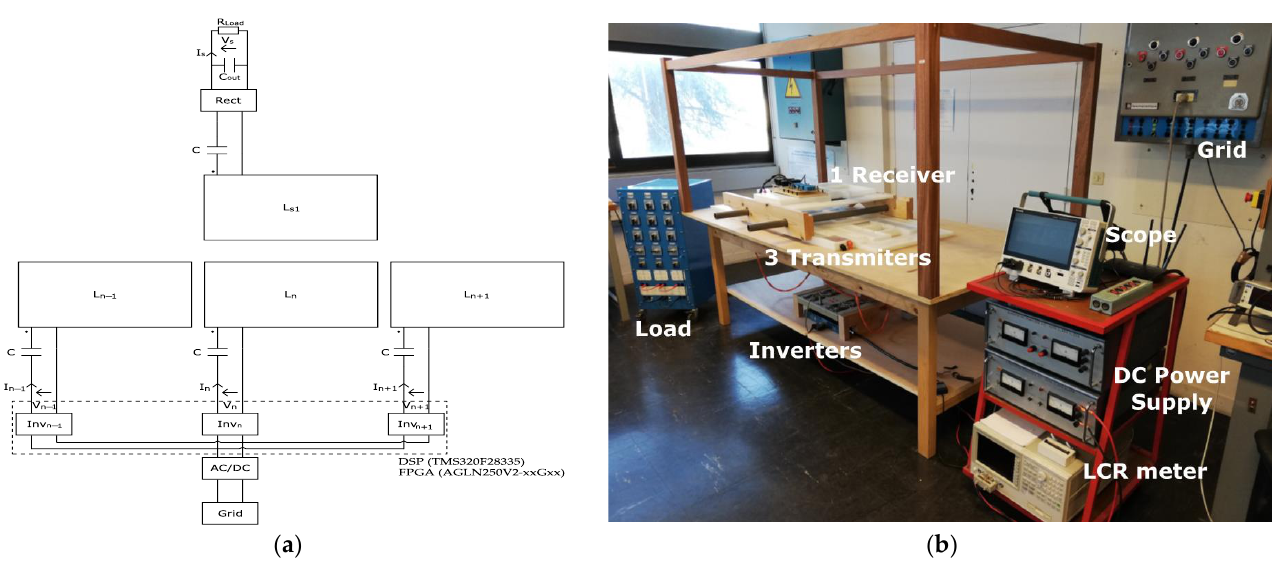
Figure 16. ( a ) Block schematics of the test bench; ( b ) photo of the test bench.